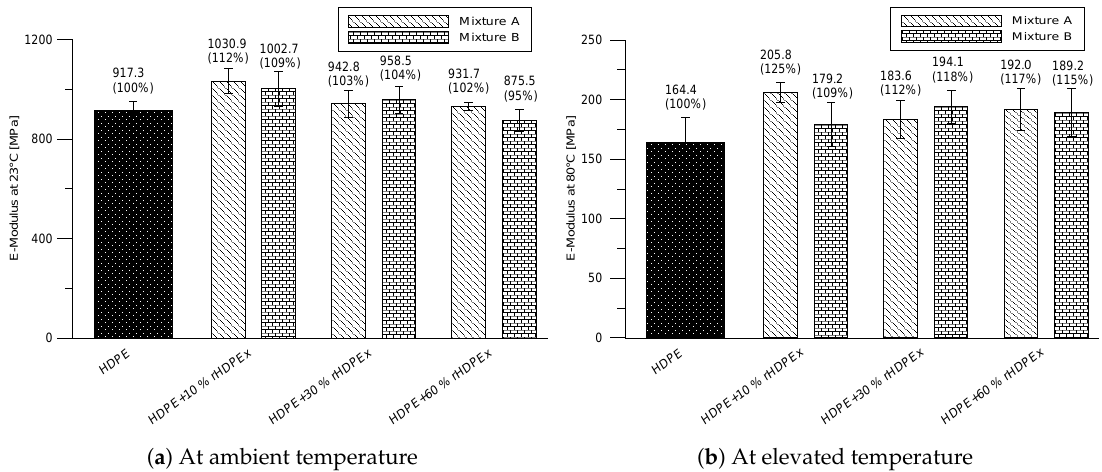
Figure 4. E-modulus of mixtures A, B.